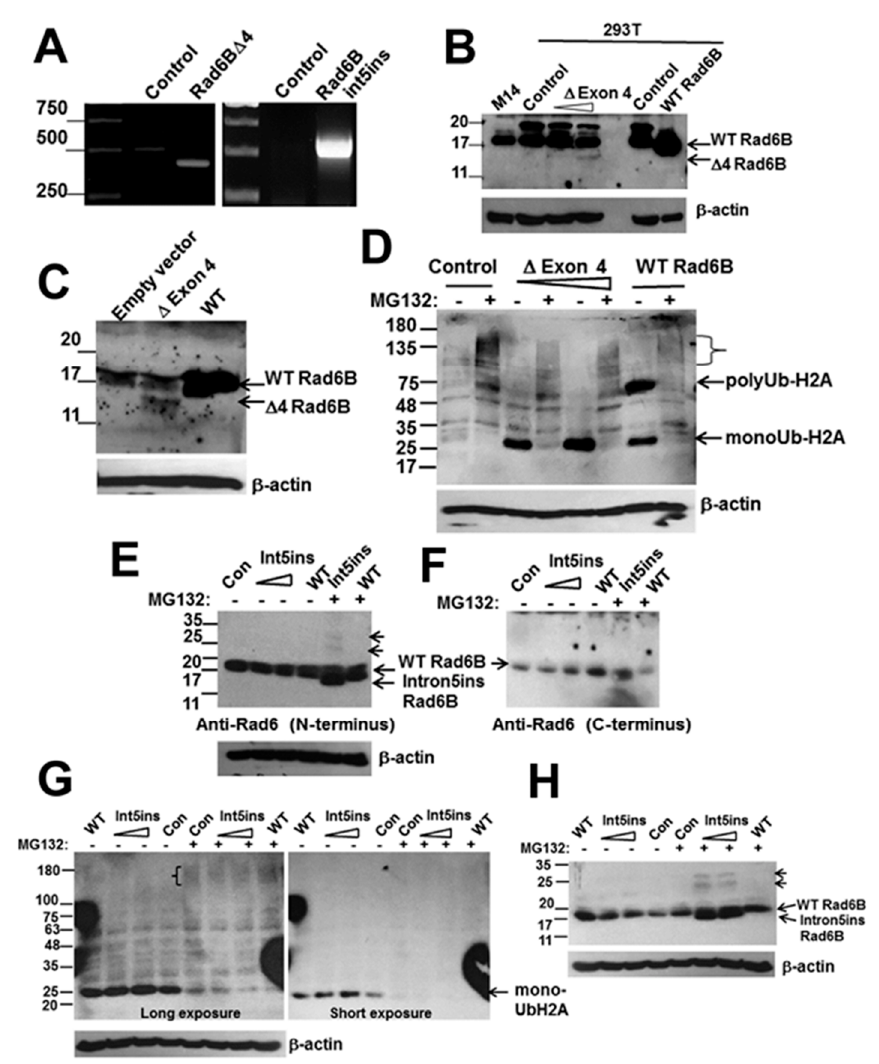
Figure 3. The splice mutants RAD6B  exon4 and RAD6Bintron5ins are catalytically active. ( A ) RT- PCR analysis of RAD6B  exon4 and RAD6Bintron5ins expressions in 293T or COS7 transfected cells. ( B ) and ( C ), Western blot analysis of RAD6B using the C-terminus reactive antibody in control, wild- type (WT) RAD6B and RAD6B Δ exon4 transfected 293T ( B ) and COS7 ( C ) cells. In ( B ), M14 cells